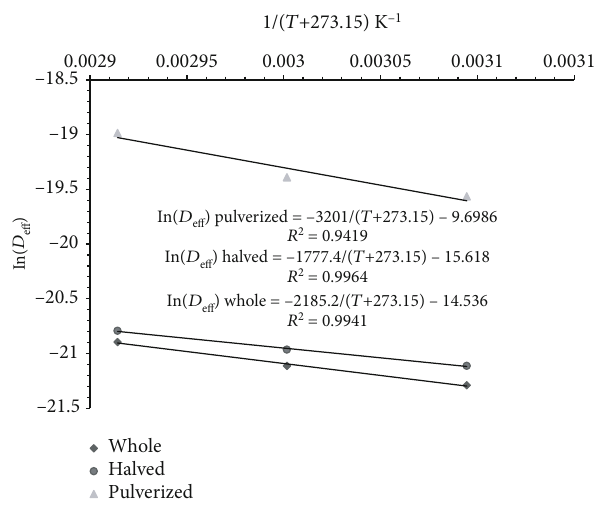
Þ against 1/ ð T + 273 : 15 Þ for the whole, eff